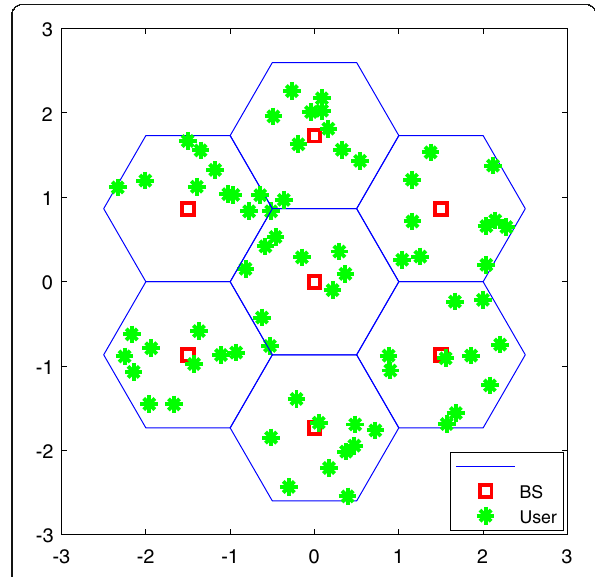
Fig. 2 Multi-cell multi-user massive MIMO system with B = 7 and K = 10